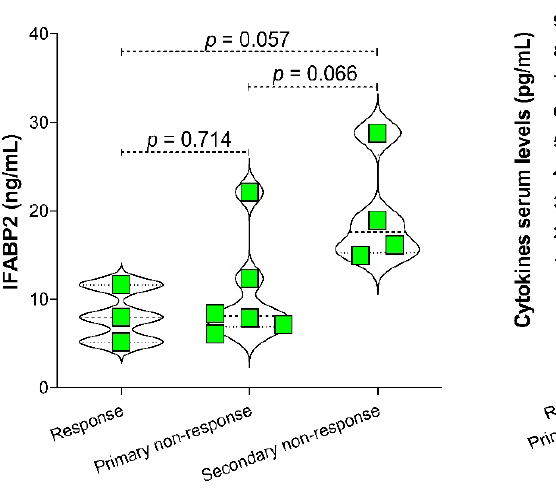
Figure 3. Association of serum levels of IFABP2 and cytokines according to clinical phenotype in RA patients with treatment. ( A ) IFABP2, ( B ) Cytokines (TNF- α, IL -10, and IL-17A). Statistical analyses were performed by Mann-Whitney U test. p -Value < 0.05 was considered statistically significant.